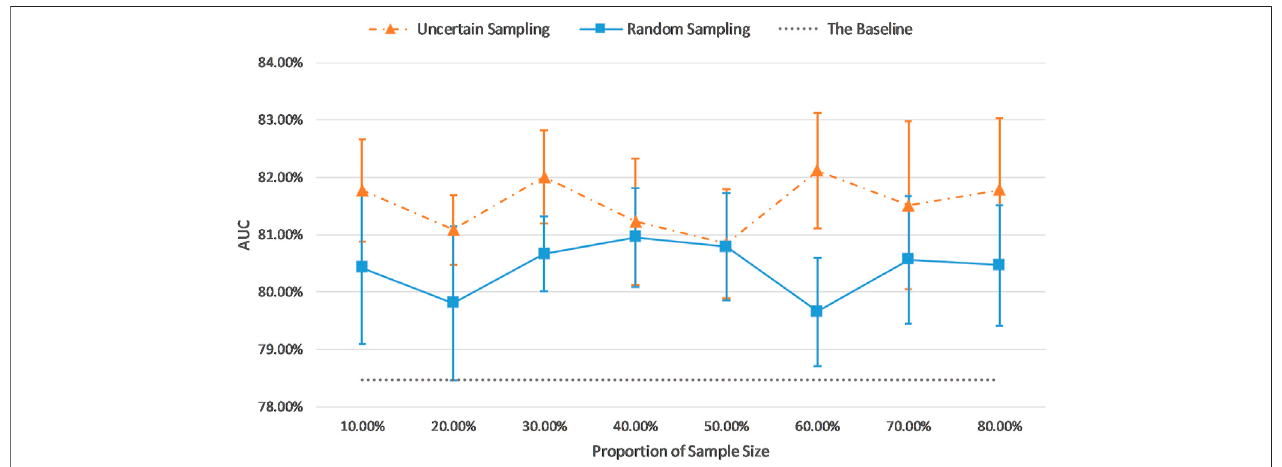
FIGURE 8 | Comparison of test AUC results of the uncertainty sampling method and random sampling method on the balanced